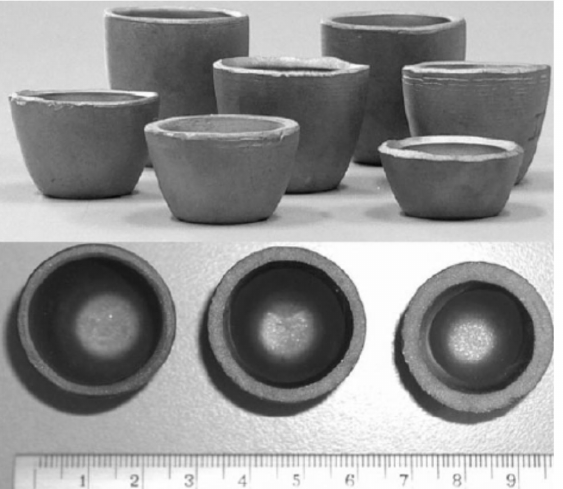
Figure 4. ZrB 2 -SiC ultra-high-temperature ceramic crucibles prepared by slip-casting. Reproduced with permission from